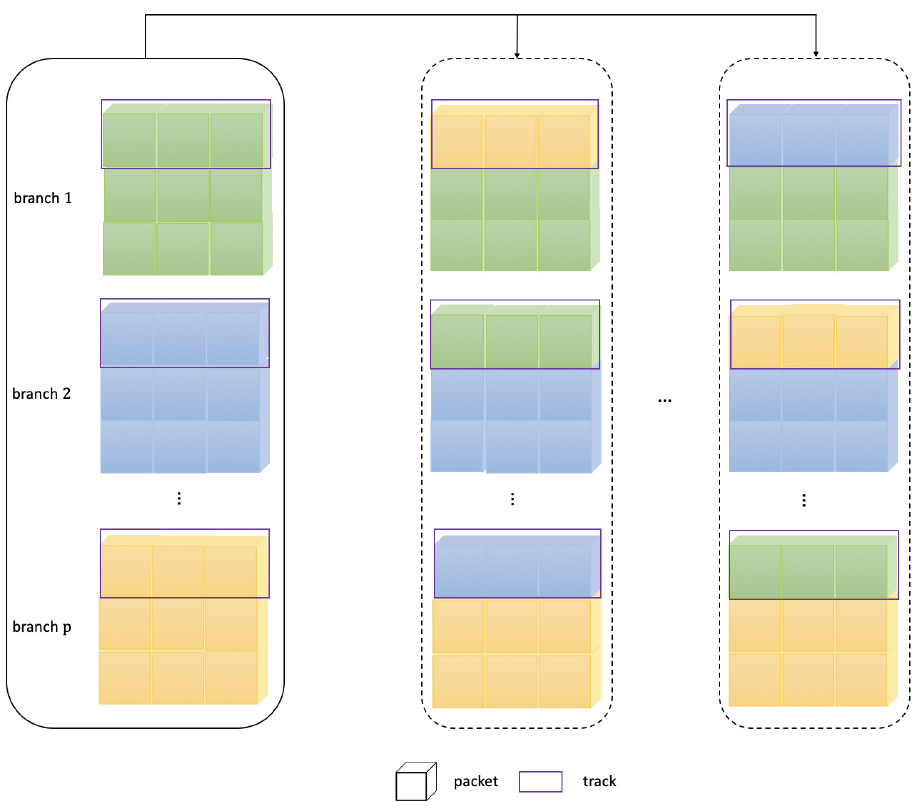
Figure 6. The feature exchanges in the different